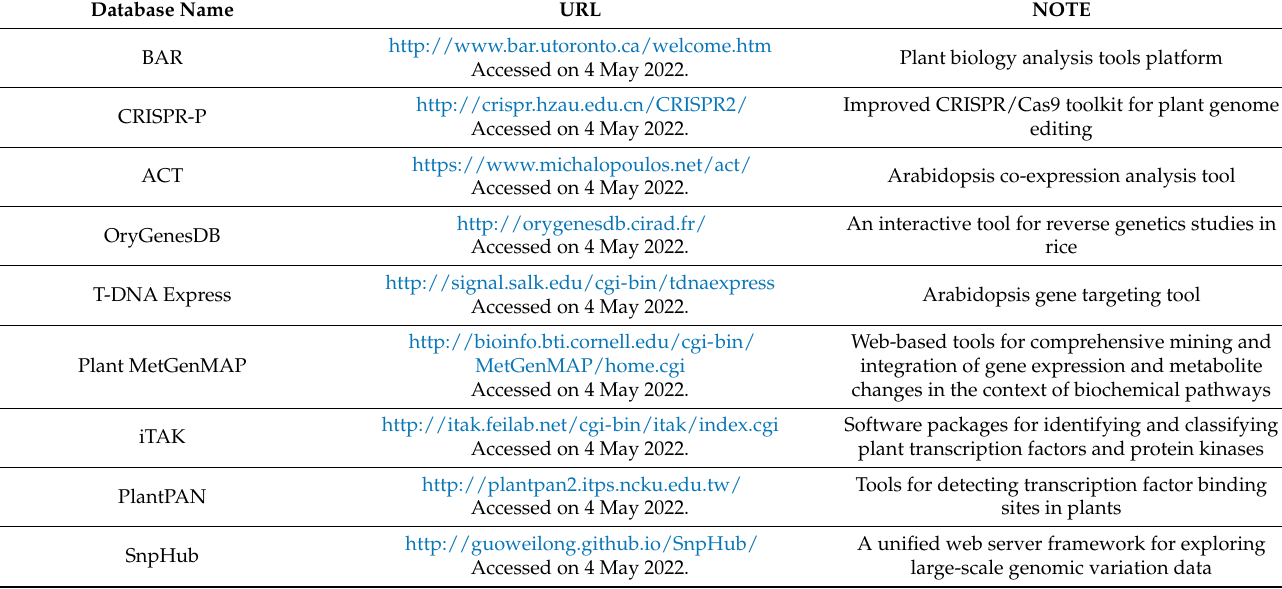
Table 5. Bioinformatics tools specific to applications in plant